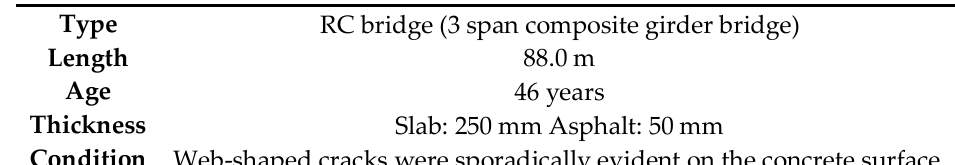
Table 1. Bridge specifications.